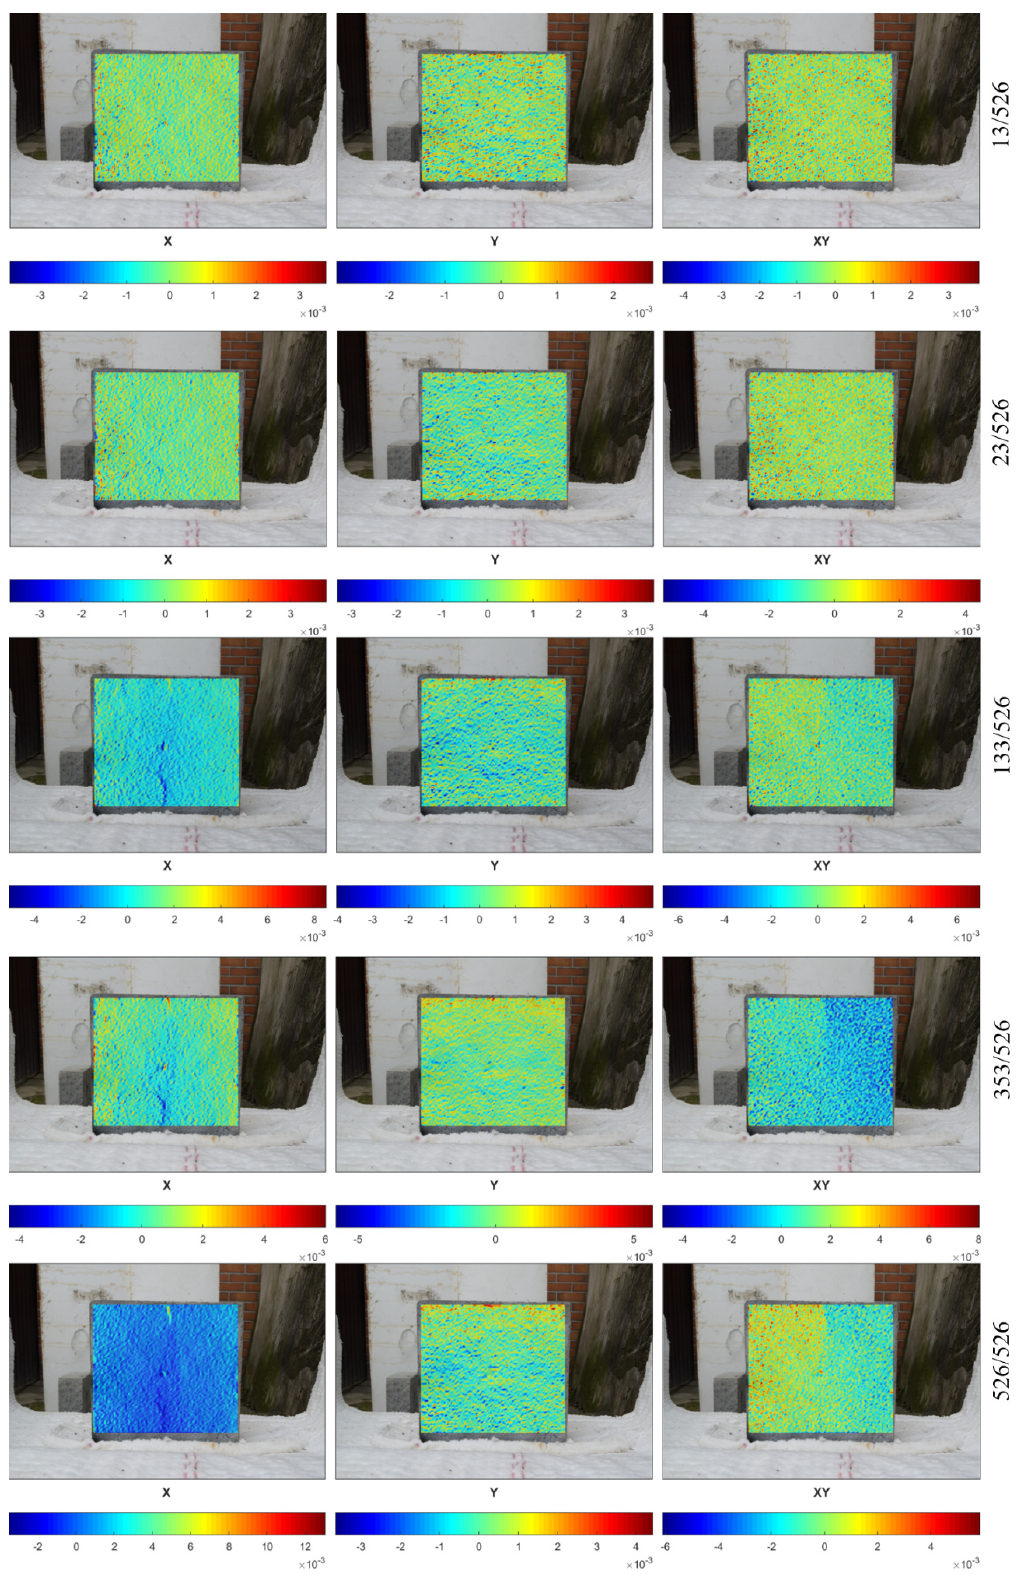
Figure 12. Deformation fields in the x- and y-directions in the unheated surface of specimen 1. The CivEng DIC method was successfully employed to measure the deformation of concrete exposed to fire at the unexposed side. The method allowed not only the deformation field across